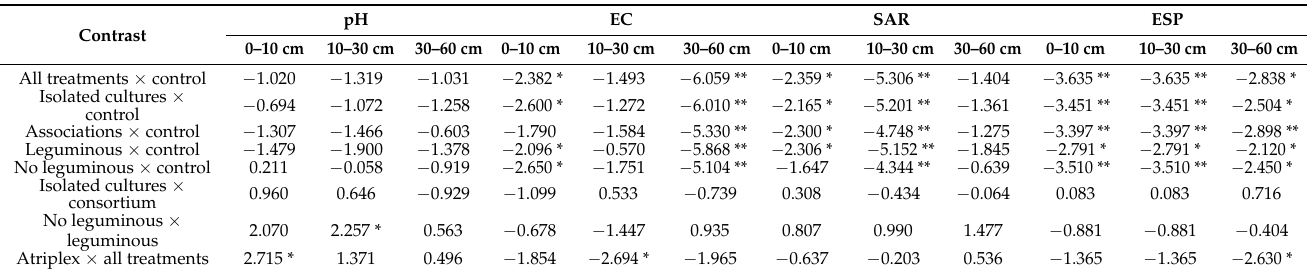
Table 5. Orthogonal contrasts of the chemical attributes pH (hydrogen potential), EC (electrical conductivity), SAR (sodium adsorption ratio), and ESP (exchangeable sodium percentage) in the soil at 0–10, 10–30, and 30–60 cm depth as a function of treatments at 18